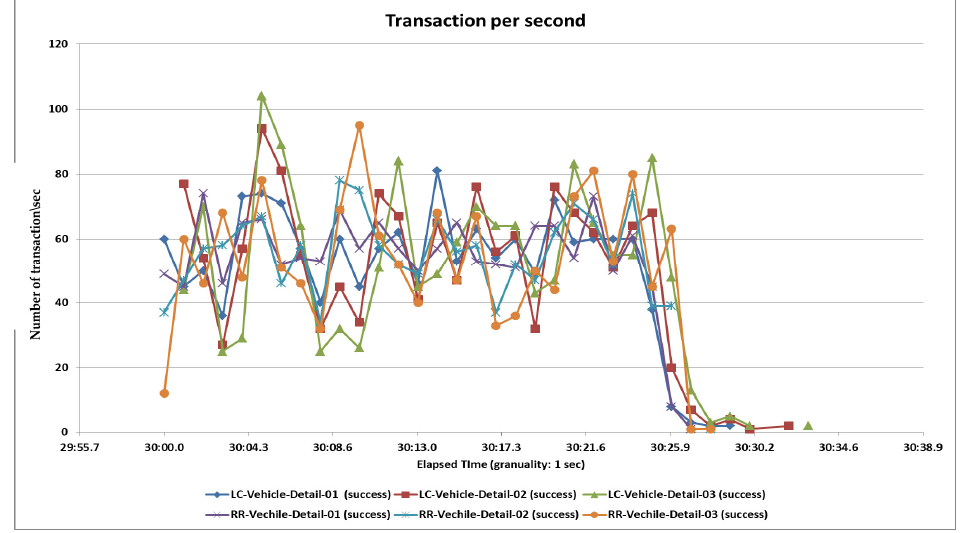
Figure 17. Throughput or transaction per second of the RR and LC Figure 17 . Throughput or transaction per second of the RR and LC algorithms. Figure 17 . Throughput or transaction per second of the RR and LC algorithms.